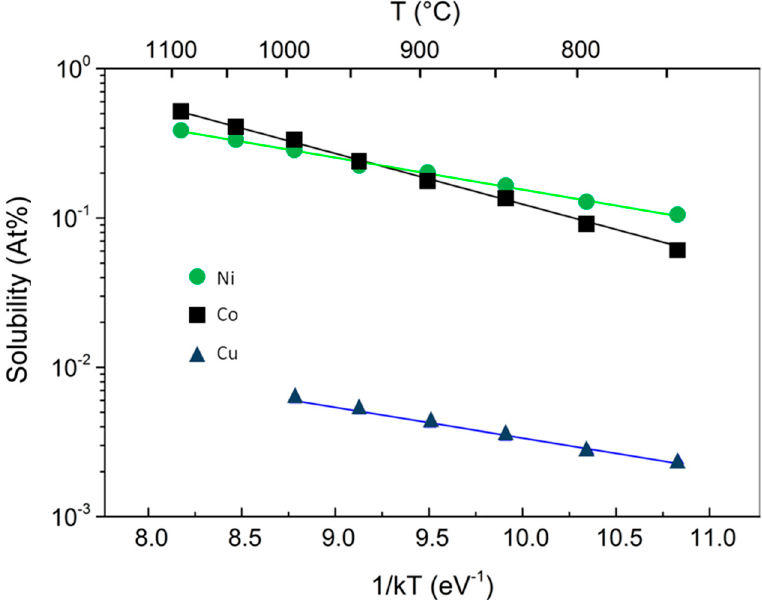
Figure 1. The dependence of the C solubility on the inverse temperature for Co (squares), Ni (circles), and Cu (triangles).